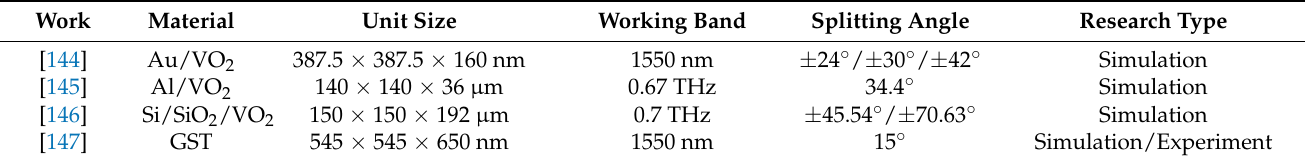
Figure 19. ( a ) Schematic diagram of the metasurface unit cell with the substrate containing VO 2 [146]. ( b ) In the insulated state, the beam splitter acts as a transmission beam splitter under TM polarized ( i ) and TE polarized ( ii ) light, respectively [146]. ( c ) In the metallic state, the beam splitter acts as a transmission beam splitter under TM polarized ( i ) and TE polarized ( ii ) light, respectively [146]. ( d ) Schematic illustration of the polarization−insensitive beam-switching phase−change metasurface [147]. Copyright 2022 John Wiley and Sons. ( e ) Optical image and intensity distribution of horizontal and vertical polarizations of transmitted beam splitters at temperatures of 145, 150, 152.5, 155, 157.5, and 200 °C [147]. Copyright 2022 John Wiley and Sons. Table 9. Parameters of tunable metasurface beam splitters for phase change materials described in this